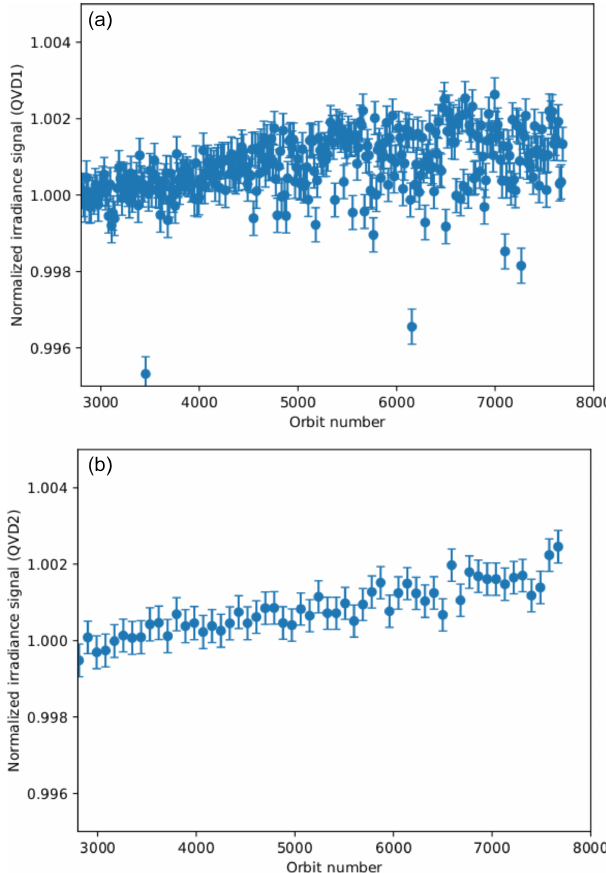
Figure 23. Median normalized solar irradiance signal as a func- tion of time. Panel (a) is the daily solar irradiance measurements, performed using the main diffuser QVD1. Panel (b) is the weekly solar irradiance measurement, performed using the backup diffuser QVD2.